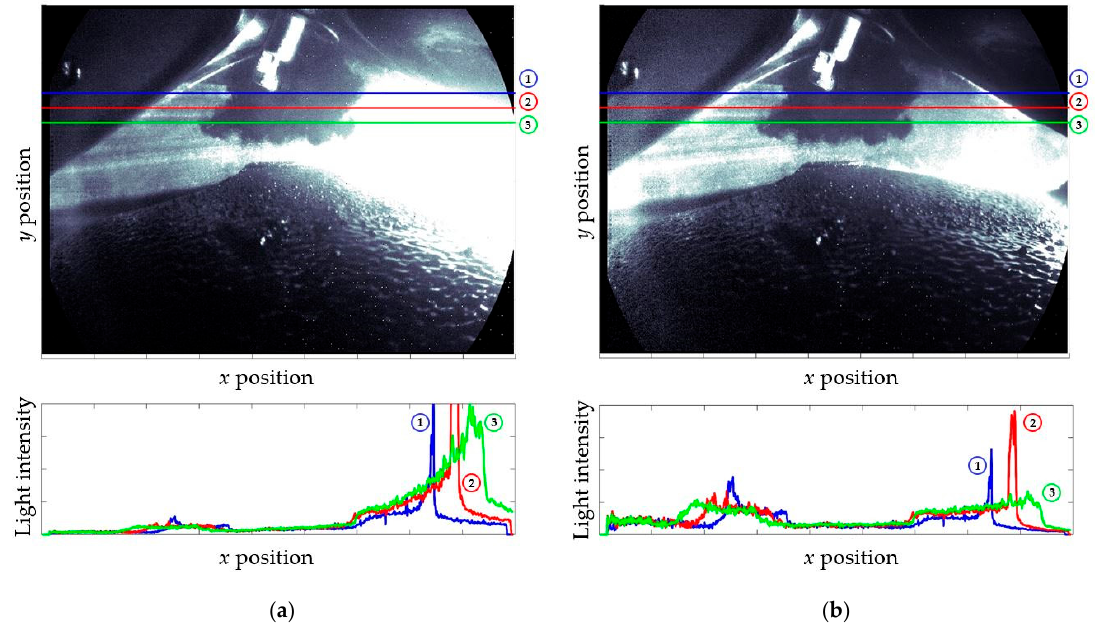
Figure 6. Light intensity plots: ( a ) raw image; ( b ) background corrected image.